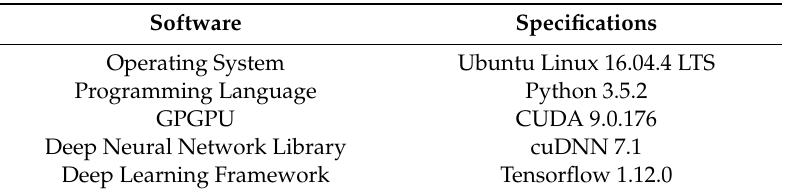
Table 2. Software specifications.